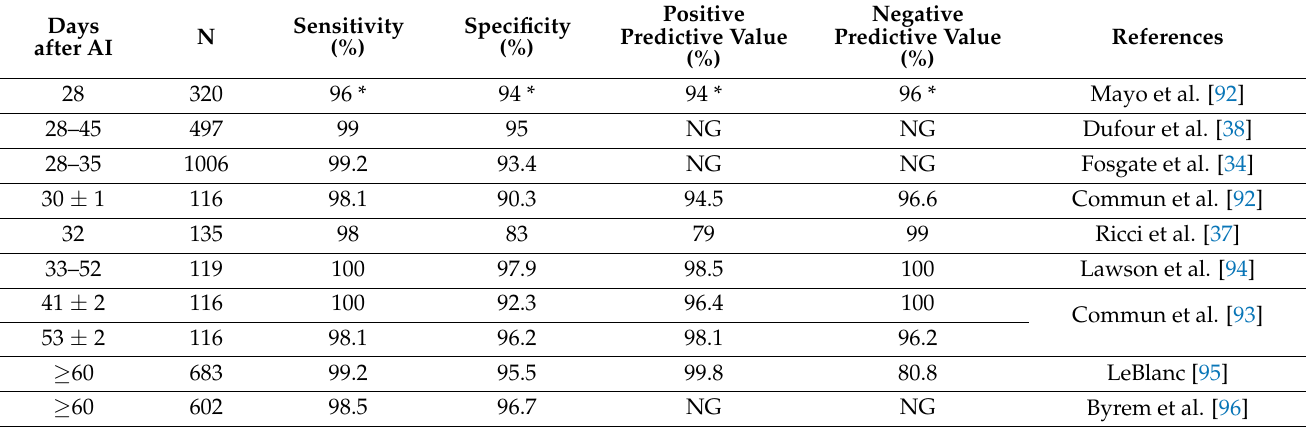
Table 8. Accuracy of commercially available milk pregnancy ELISA tests for diagnosing early pregnancy in dairy cattle. Days Sensitivity N after AI